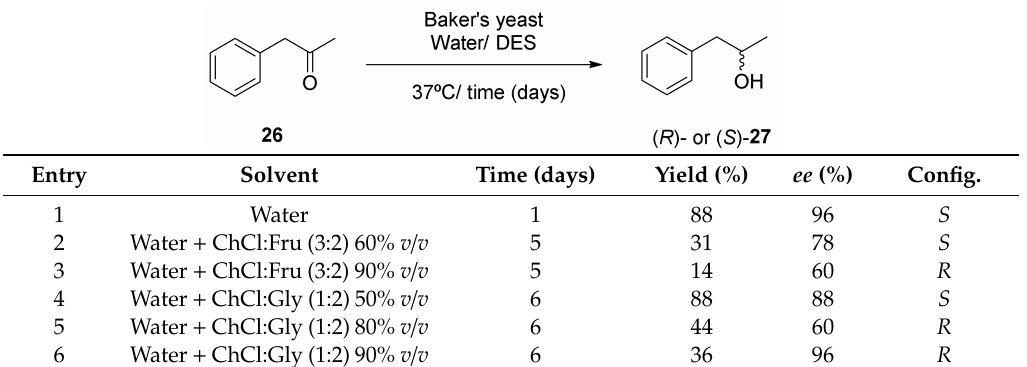
Table 2. Baker’s yeast catalyzed bioreduction of phenylacetone ( 26 ) in presence of di ff erent choline chloride-based DESs containing D-fructose or